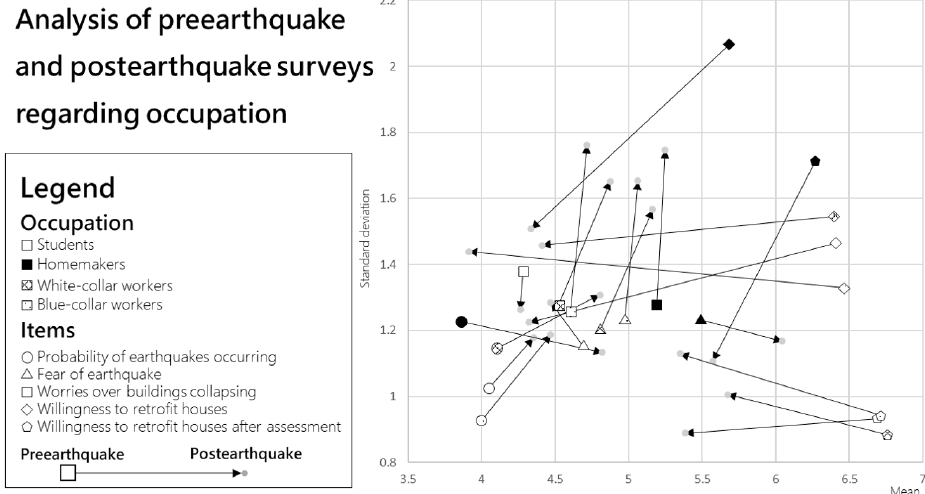
Figure 5. Comparative analysis of the pre- and postearthquake surveys regarding